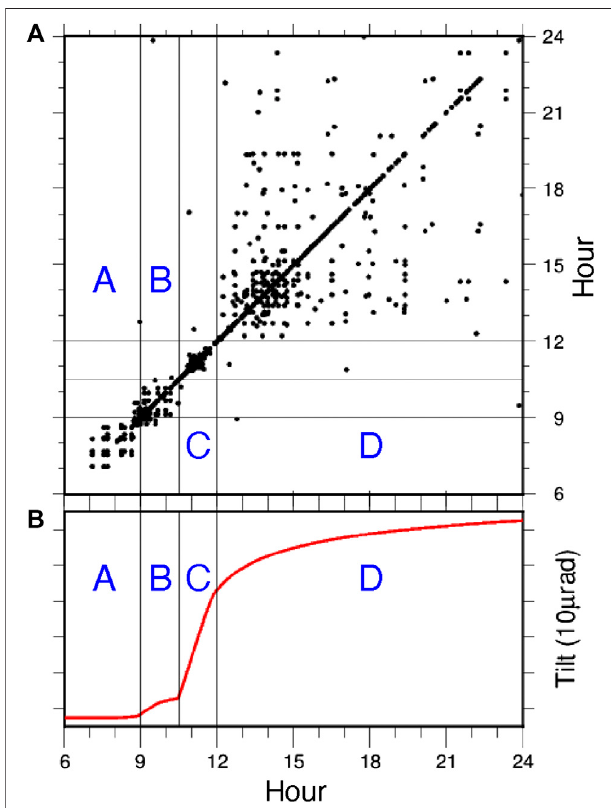
FIGURE 4 | (A) Occurrence times of the earthquakes with cross- correlation coef fi cients of ≥ 0.7 (black circle) and (B) tilt change at the station AR1 (red line). The tiltmeter is directed toward the Minami-dake (MD) crater. The lines indicate 9:00, 10:30, and 12:00 JST on August 15, 2015. The letters A, B, C, and D show time periods as de fi ned in this study.